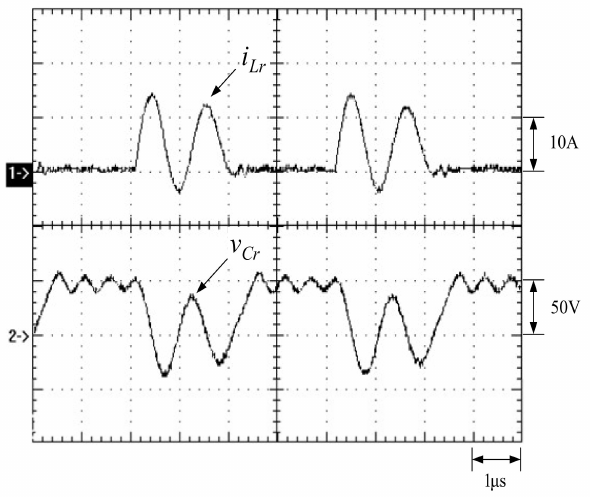
Figure 10. Resonant waveforms: (1) i Lr ; (2) v Cr